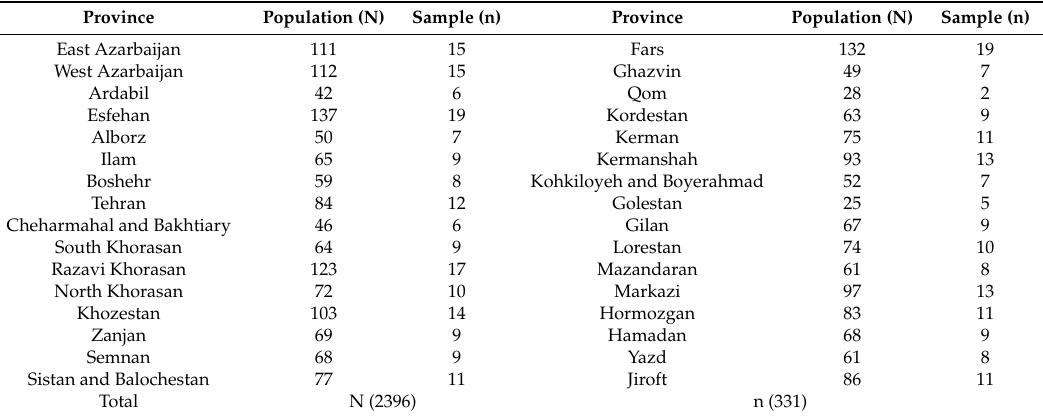
Table 1. The number of the statistical population and sample for research in different provinces of